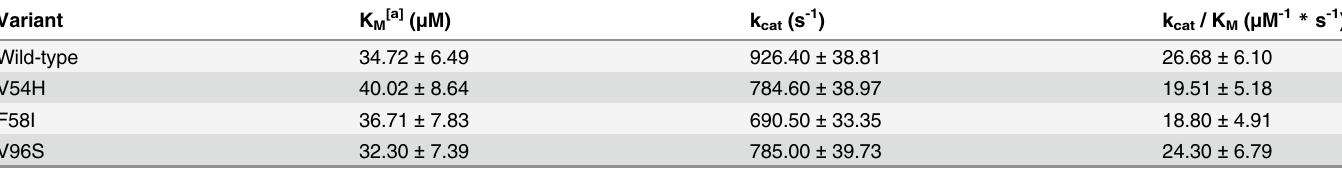
Table 3. Kinetic parameters of Bs LipA variants and wild-type.